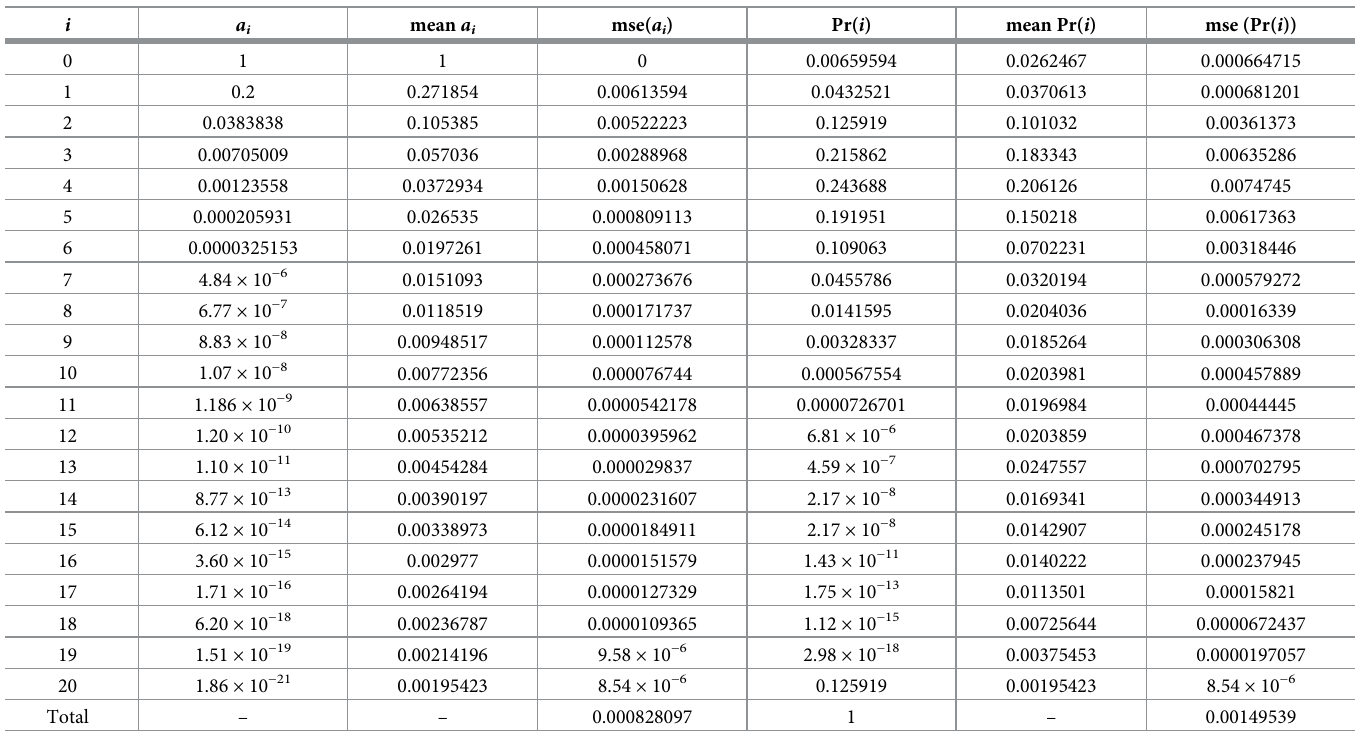
Table 3. Scenario 1. H (100, 20, n ) where n = 5, 10,